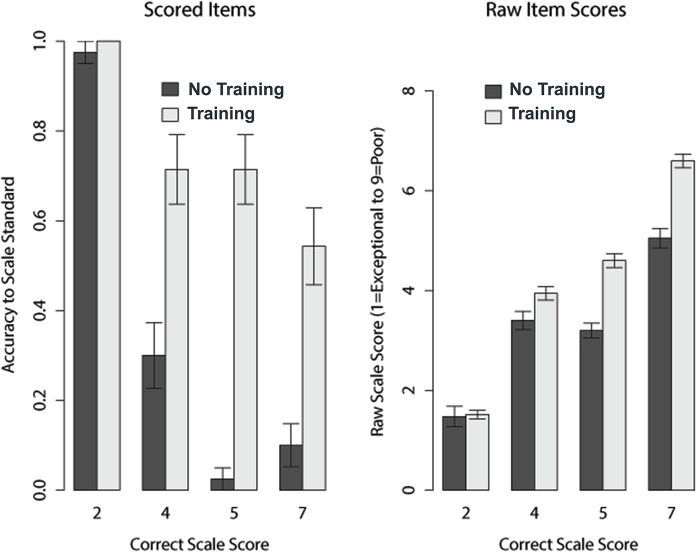
Performance on the four rating scale items (scored and raw items).